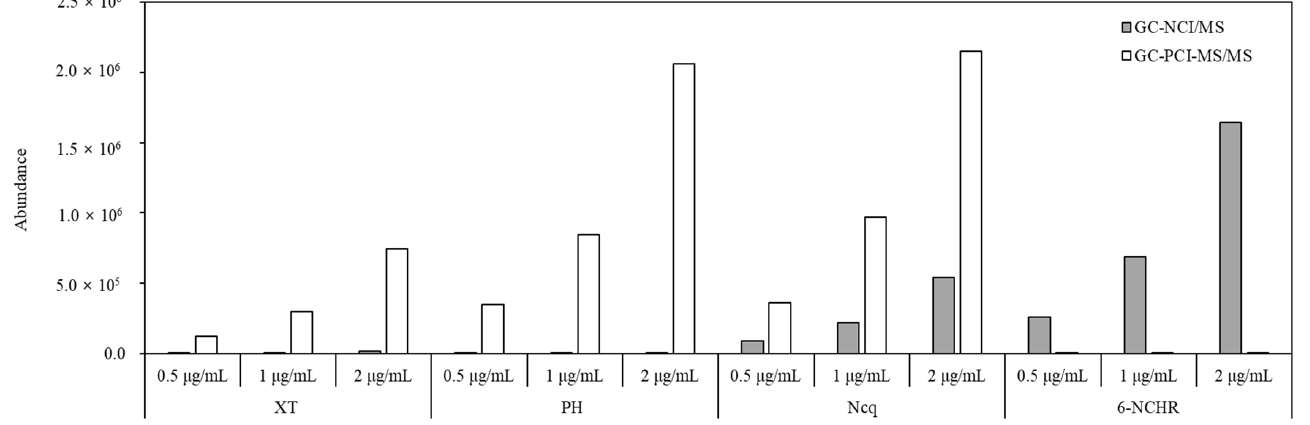
Figure 3. Comparison of the sensitivity of XT, PH, Ncq, and 6-NCHR at three different concentra- tions obtained by GC-NCI/MS and GC-PCI-MS/MS.